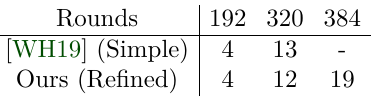
Table 10: Score of the best Type 4 trail found for number of rounds evaluated by the original submission